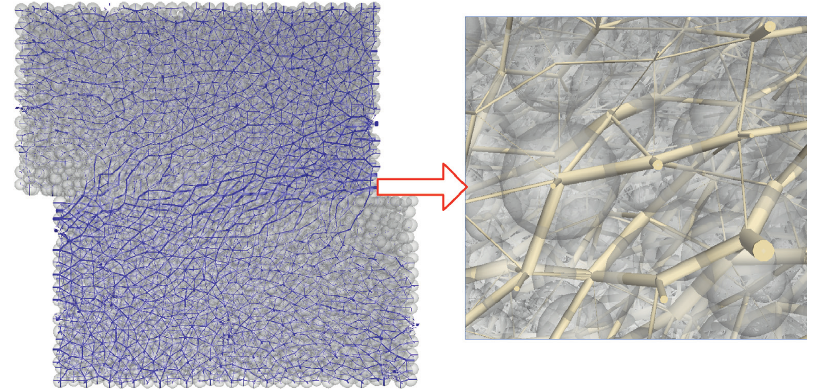
Figure 10: Schematic diagram of contact force